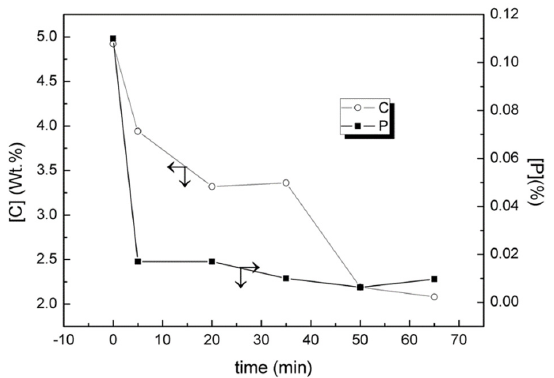
Figure 3. Phosphorus and carbon content with